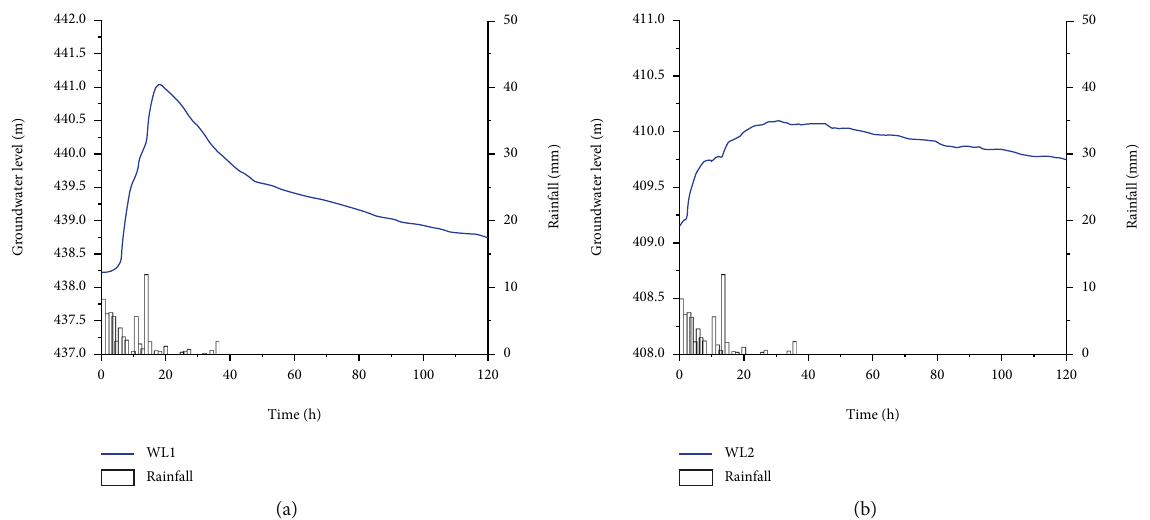
Figure 8: Relationship between rainfall and groundwater level during the study period. (a) Monitoring point A. (b) Monitoring point B.